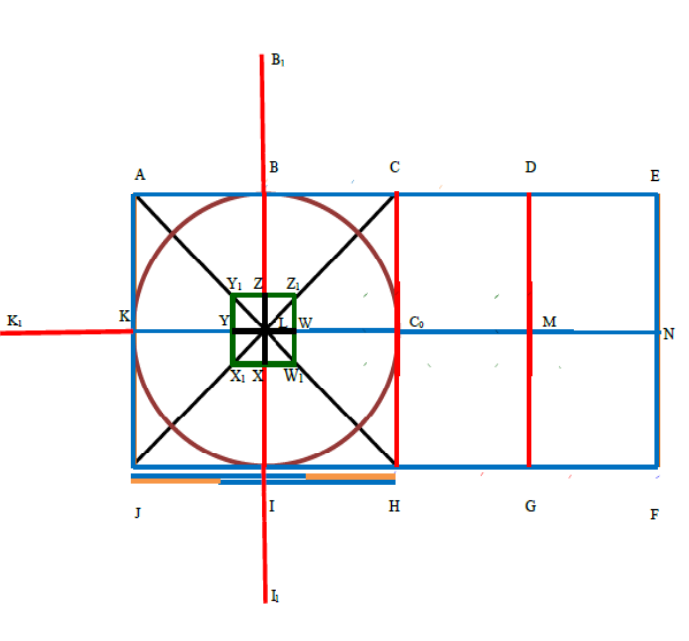
Figure 5. Golden section of ACHJ.